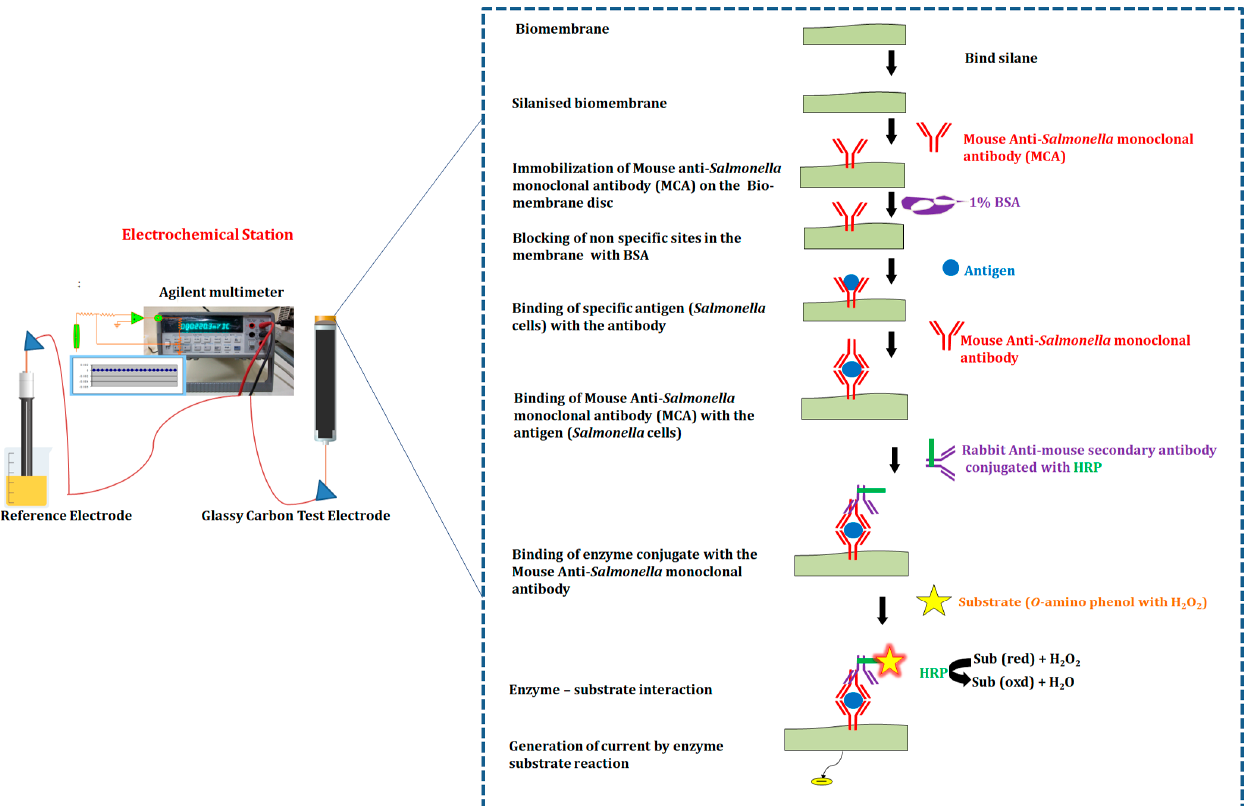
Figure 7. Diagrammatic illustration of immunosensor membrane preparation, operating procedure and detection of Salmonella